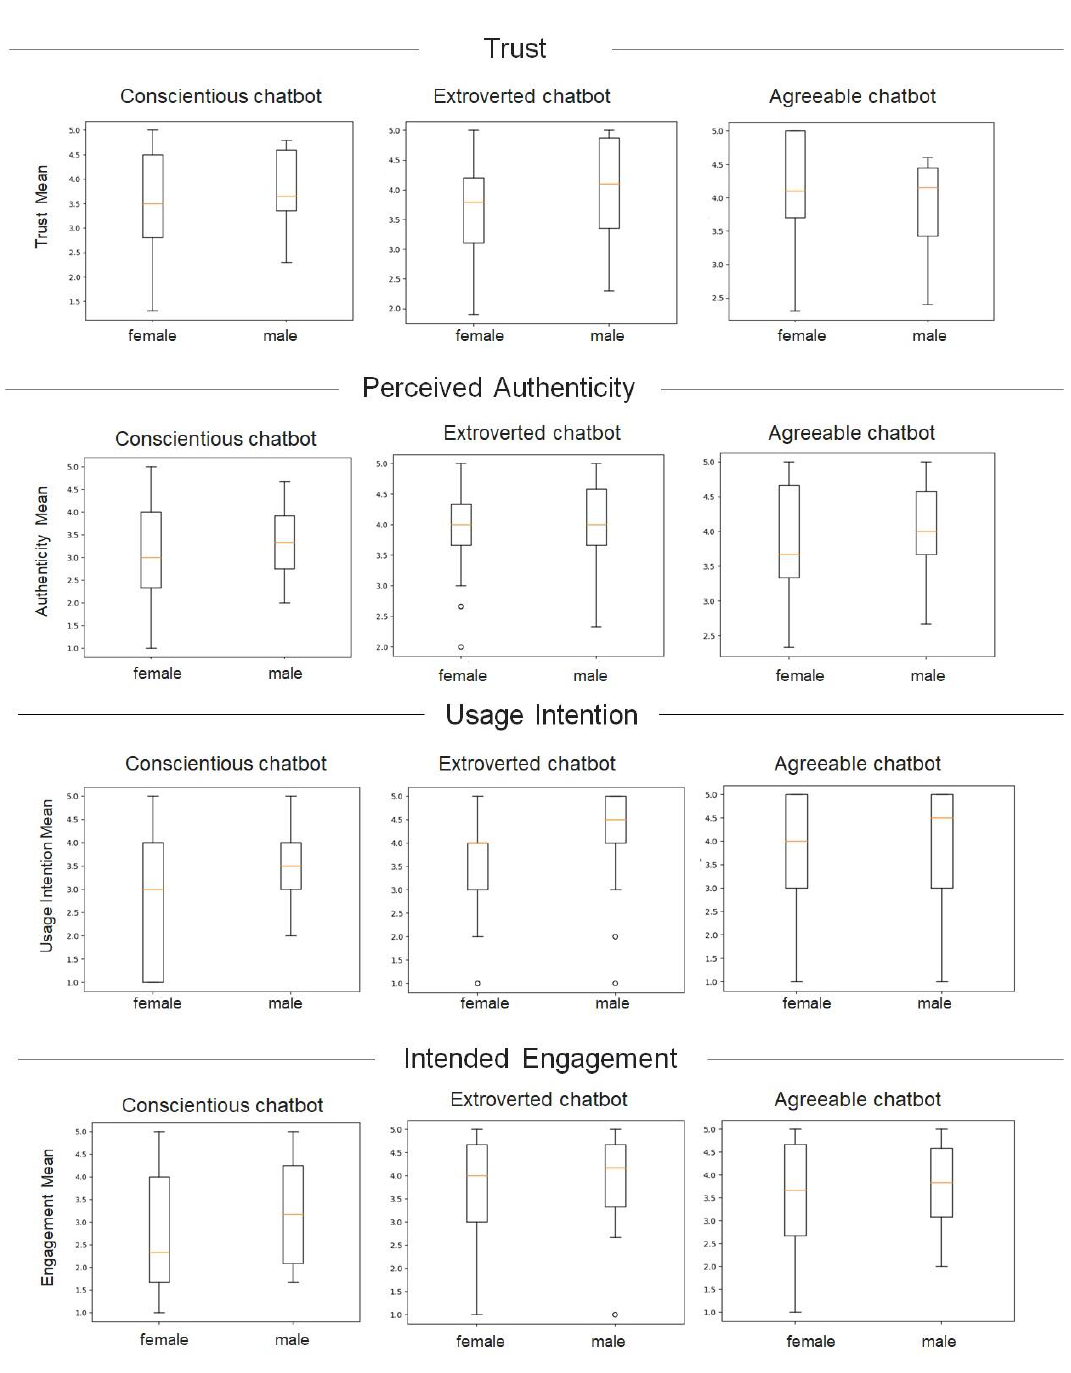
Figure 6. A box plot of trust, perceived authenticity, usage intention, and intended engagement ratings for chatbots categorized by gender.